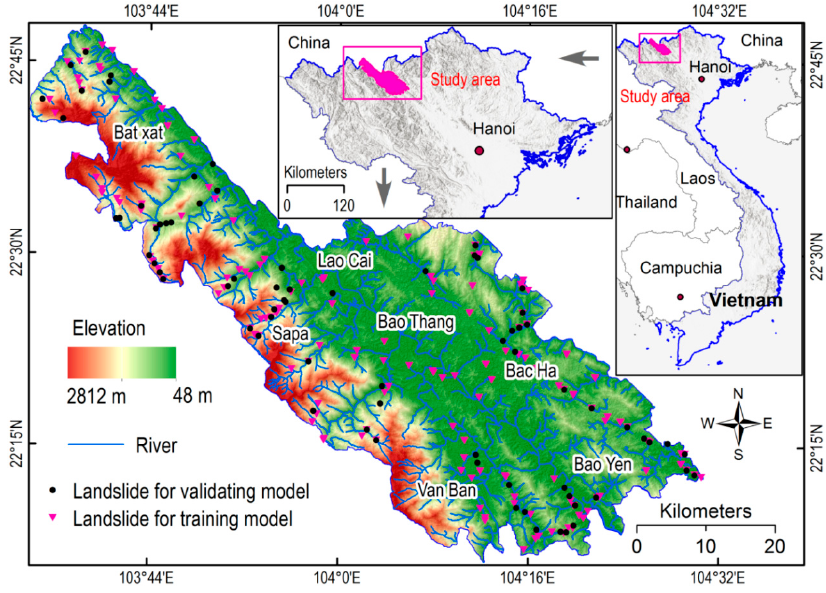
Figure 1. Location of the Upper Reaches Area of Red River Basin (Vietnam).